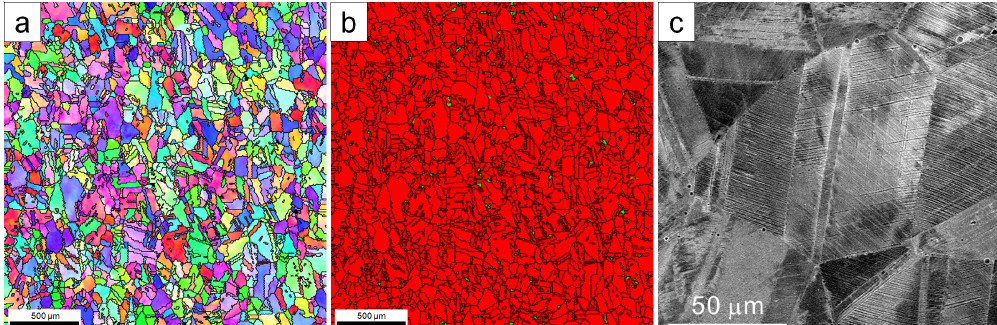
Figure 5. Relationships between the martensite phase fraction and the rolling reduction in the CCM and CCWN alloys. EBSD: Electron backscatter diffraction.